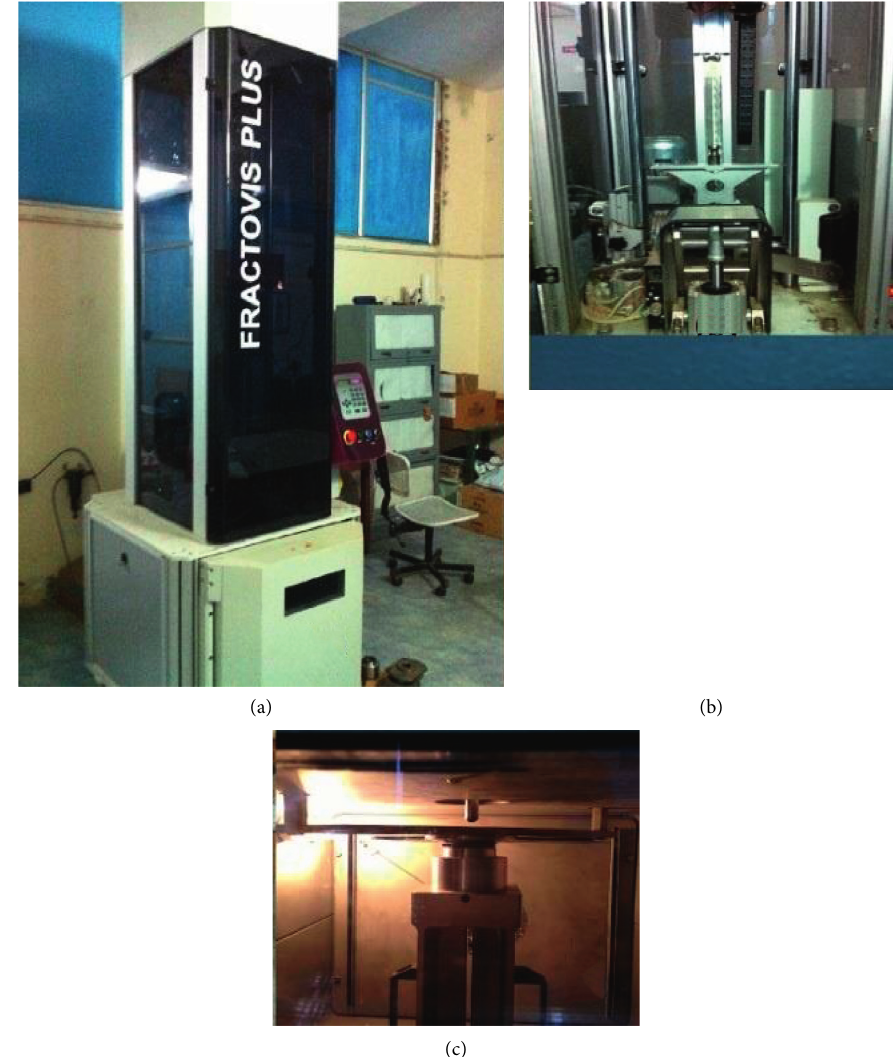
Figure 1: (a) Fractovis instrumented impact tester. (b) Impact striker with the load cell. (c) Specimen holder, clamped during impact.